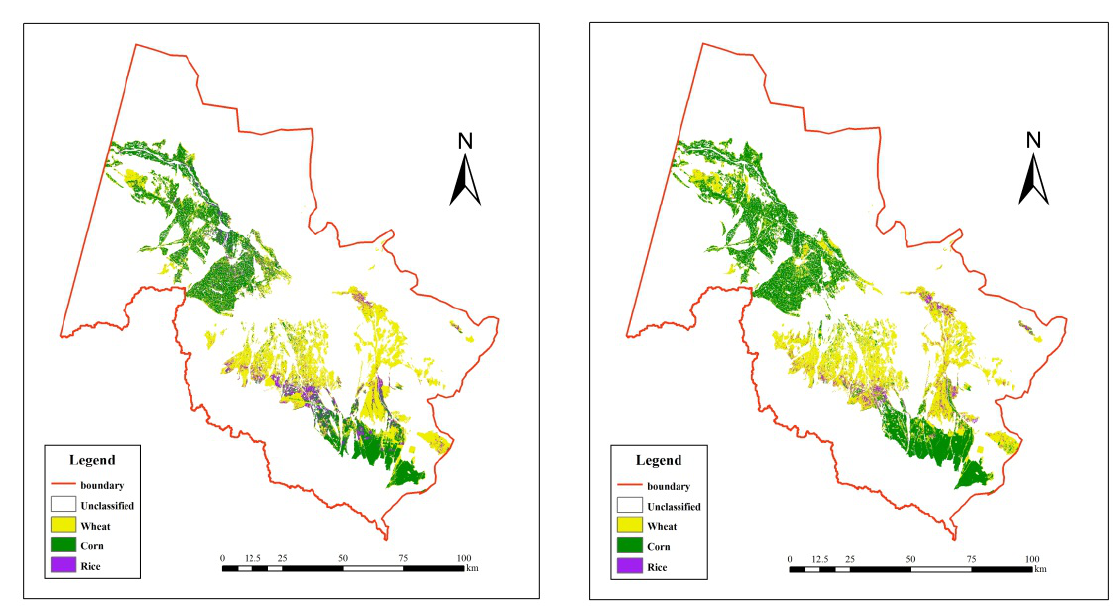
Figure 3. The agricultural types within the selected subset in August, 2000 (left) and 2009 (right).